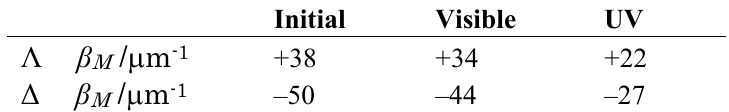
Table 5. Photo-modulation of HTP in 0.2% solutions of enantiomeric [Ru(acac) doped in ZLI-1132 at 35.0 °C . The experiments were performed for one sample so that they might contain a large error (this table is a modified version of one in reference